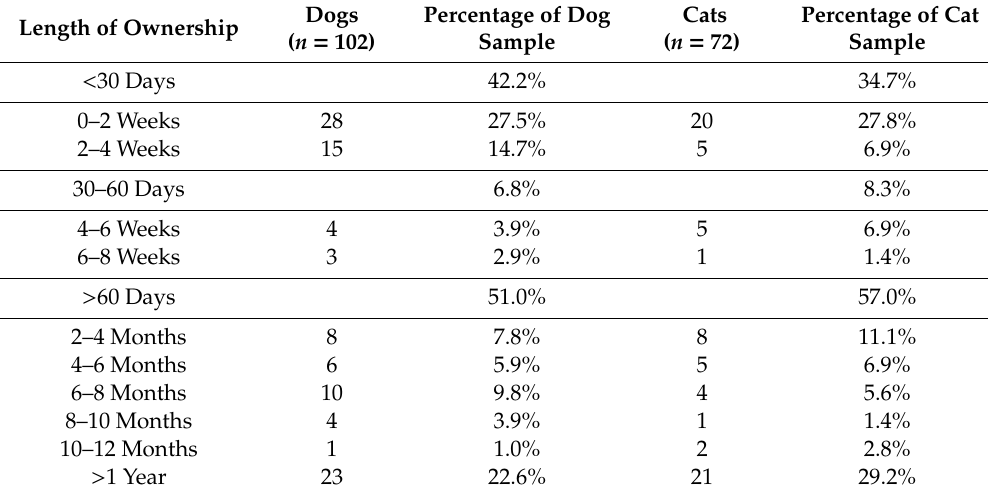
Table 6. Length the dog or cat was owned prior to return by number of animals and the percentage of the